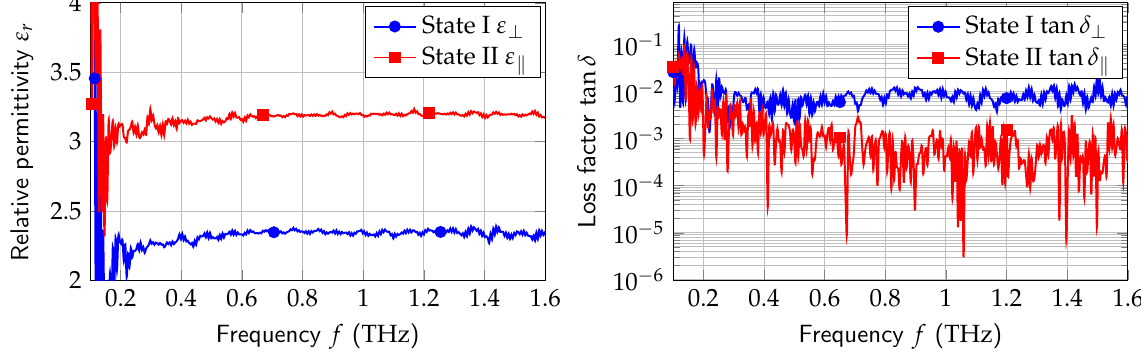
Figure 9. THz characterization results for the LC GT3-23001 from Merck KGaA, Darmstadt,